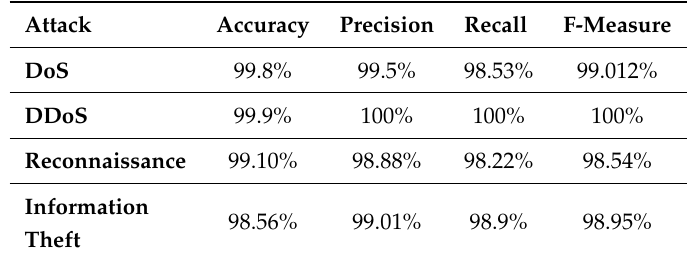
Table 8. DeepDCA Performance Evaluation Metrics in Different Attack